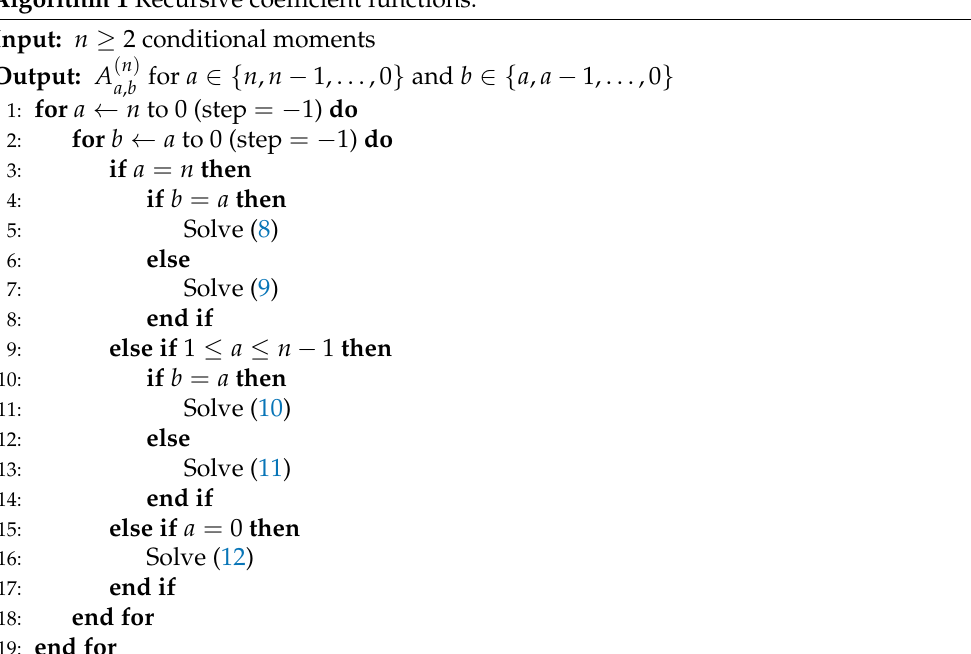
Algorithm 1 Recursive coefficient